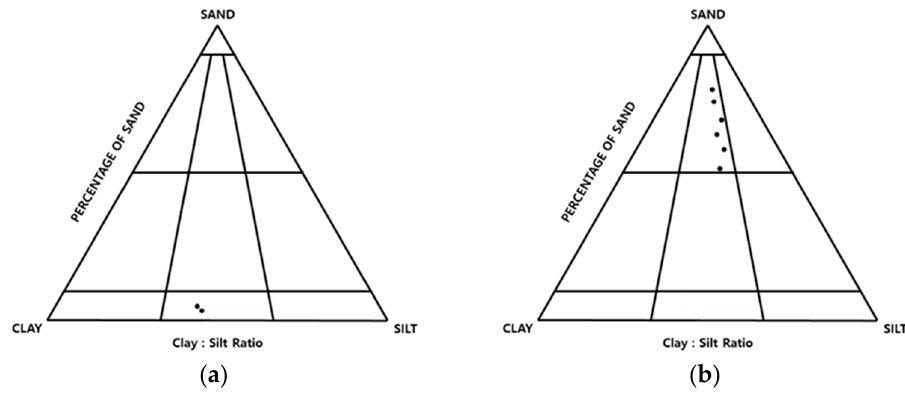
Figure 3. Ternary diagrams of sand-silt-clay; ( a ) Site 1, ( b ) Site 2. Table 1. Averaged sediment